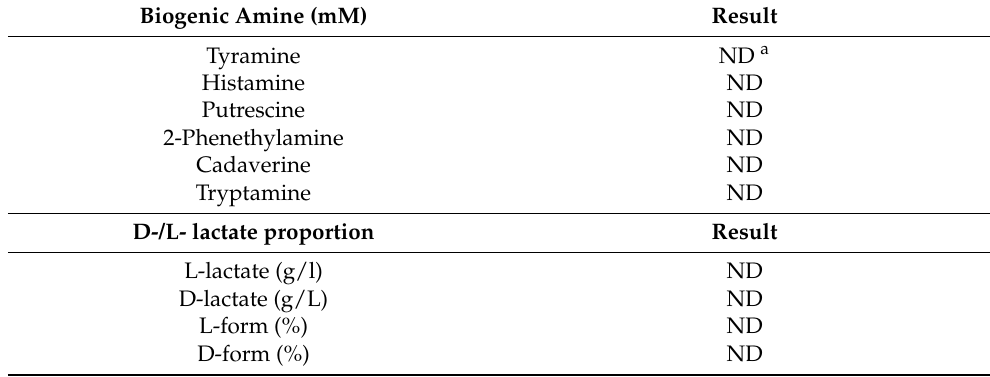
Table 10. Biogenic amine concentration and L-/D-lactate proportions in CFS of B . subtilis IDCC1101.